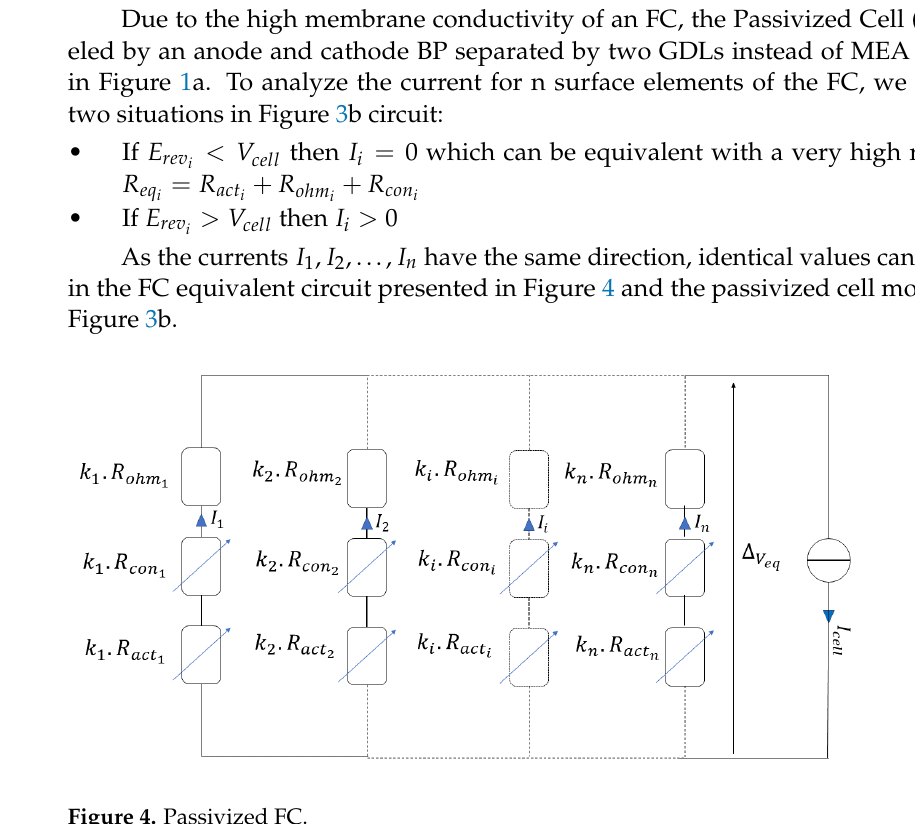
Figure 4. Passivized